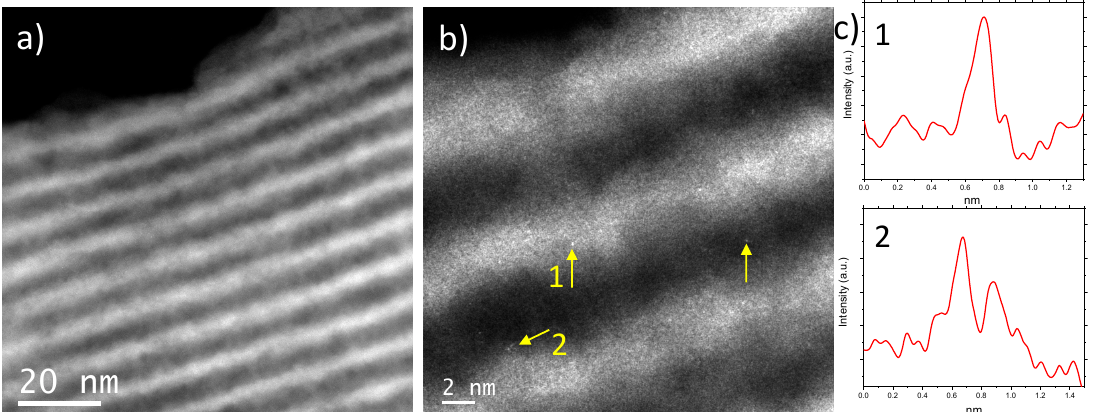
Figure 5. C s -corrected STEM-HAADF micrographs of 0.20-Au-8d. ( a ) Data recorded perpendicularly to the pore channels. ( b ) A closer look allowing the visualization of Au atoms, yellow arrows. ( c ) Intensity profiles extracted along the signals numbered as 1 and